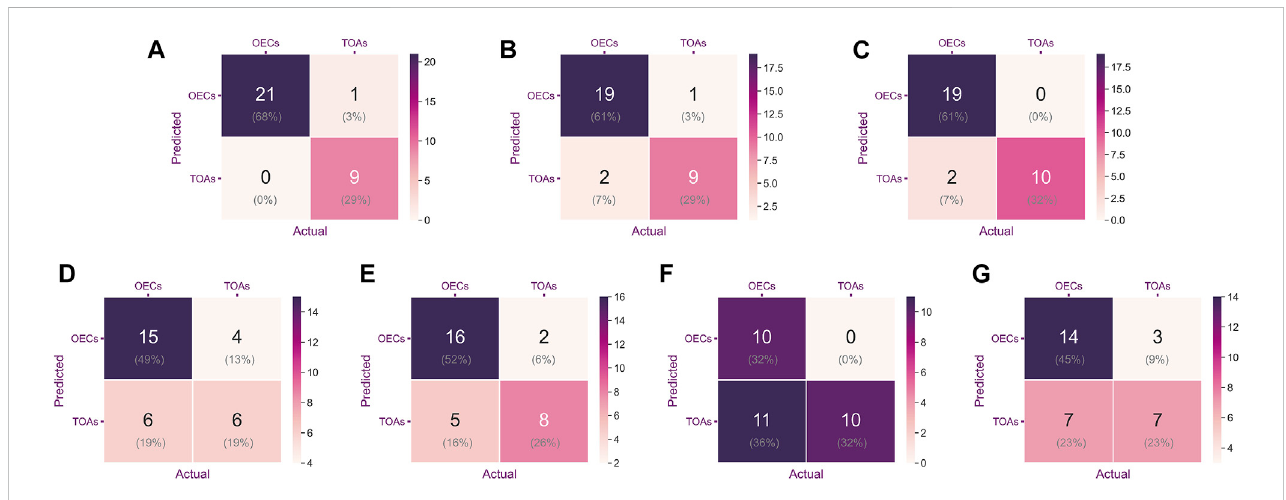
FIGURE 4 Confusionmatrixwasusedtoevaluatetheclassi fi cationaccuracyofamodelorindicator.Theupperleftandlowerrightcornersrepresentthenumberof accurate predictions. From left to right are ResNet-152 (A) , DenseNet-161 (B) , Ef fi cientNet-B7 (C) , CA125 (D) , Reader 1 (E) , Reader 2 (F) , and Reader 3 (G) .